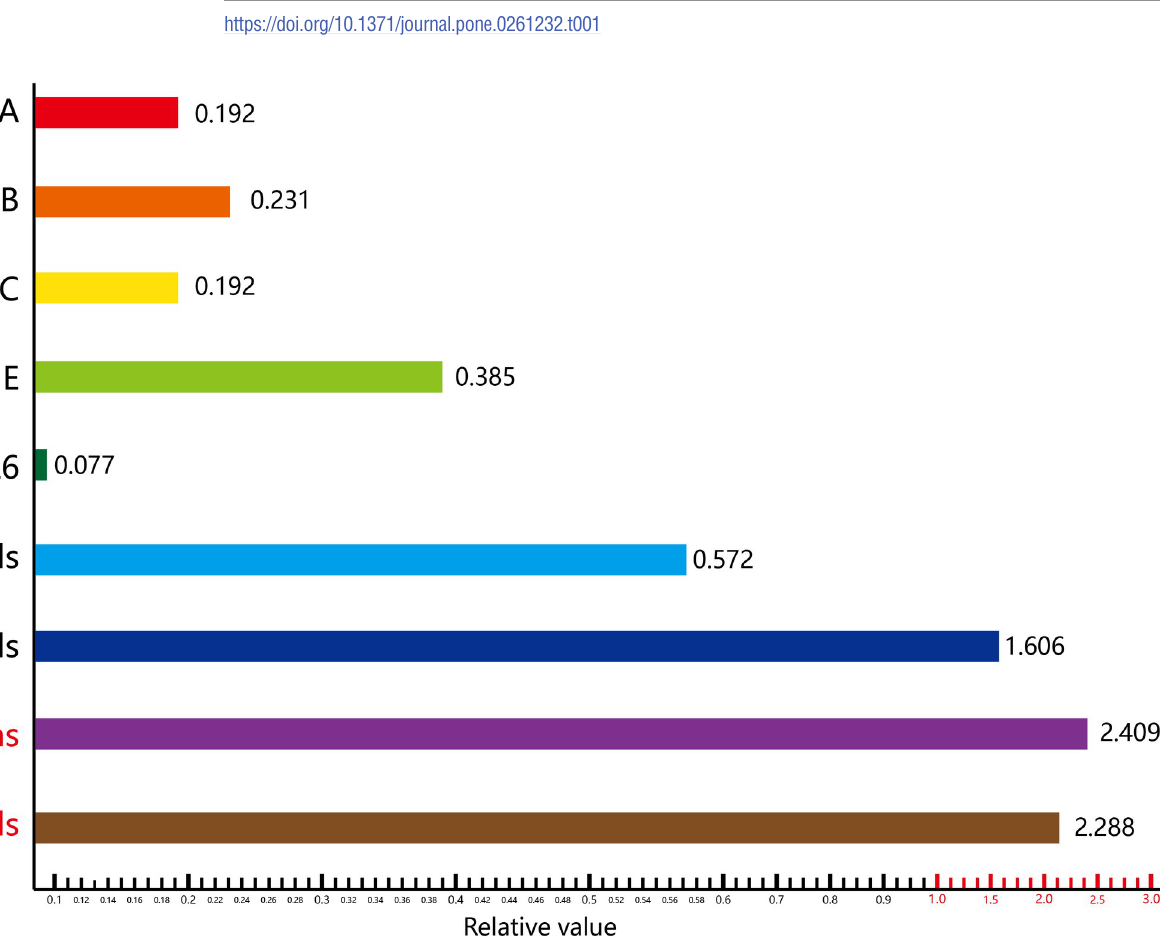
PLOS ONE | https://doi.org/10.1371/journal.pone.0261232 January 21,